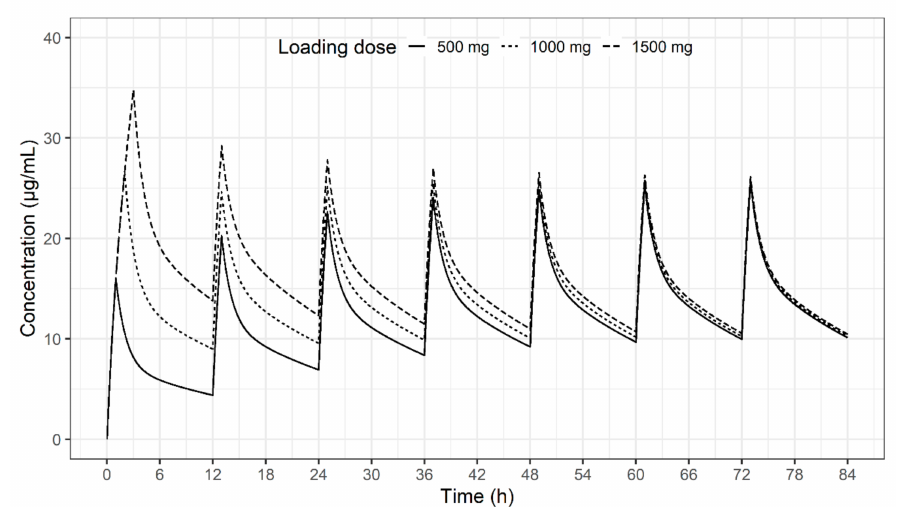
Figure 5. Concentration-time profile of vancomycin following three di ff erent loading doses and a maintenance dose of 500 mg every 12 h at a dose of 500